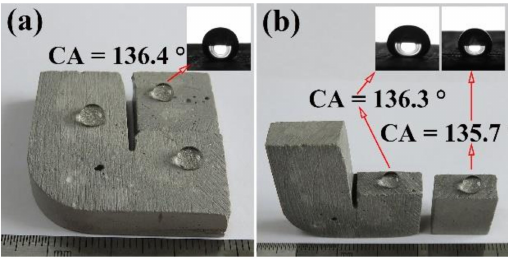
Figure 4. Photos of water droplets on di ff erent surfaces of HCPSL1.0NS1.0: ( a ) as-prepared surface; ( b ) newly exposed surface after being broken.